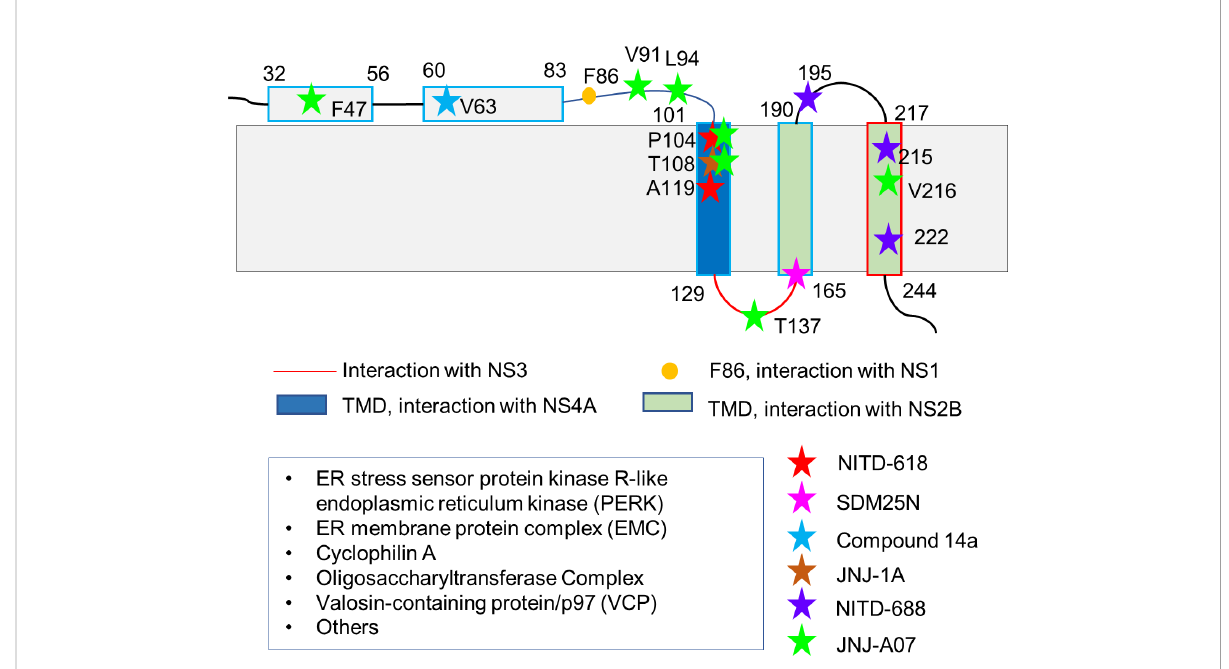
FIGURE 2 Residues of NS4B critical for inhibitor and protein bindings. The membrane topology of NS4B determined with biochemical assays is shown as this topology was used in most functional studies. Some residues involved in PPIs and inhibitor bindings are indicated and highlighted in different color. Some identi fi ed host proteins interacting with NS4B are listed in the